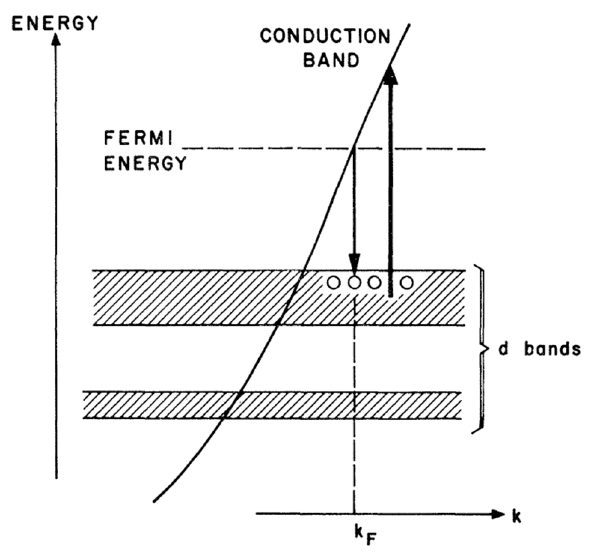
Figure 2. Schematic band structure of a noble metal showing the excitation and recombination transitions. Reprinted with permission from Ref. [29]. Copyright (1969) American Physical Society.